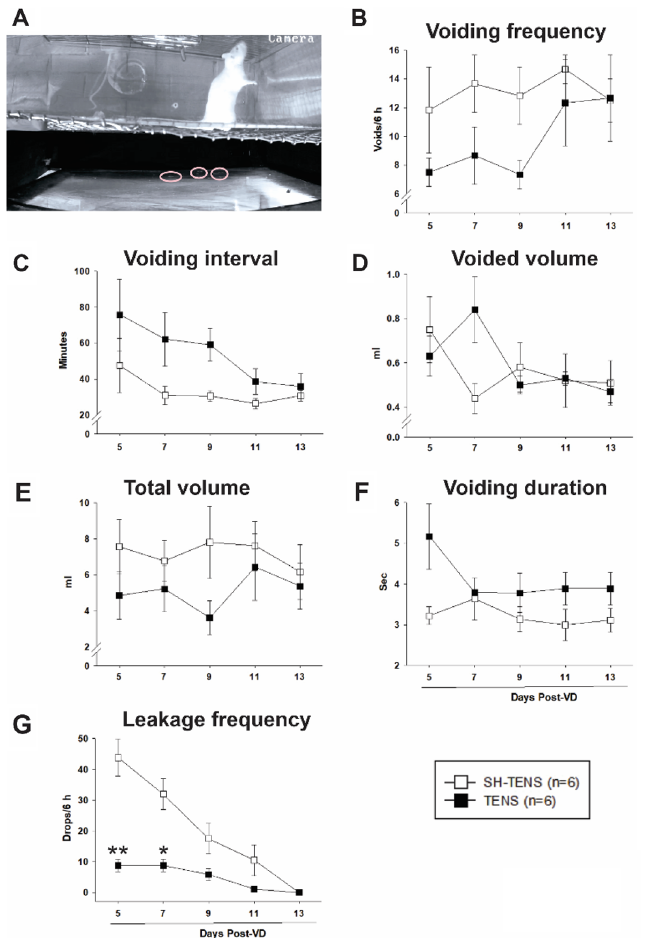
Figure 7. Urinary parameters of rats treated with transcutaneous electrical nerve stimulation (TENS) after vaginal distension (VD). ( A ) Photograph of a female rat standing on the hind-legs for vertical exploration with concomitant urine leakage (ovals indicate the drops expelled). Urinary parameters during the dark phase after VD or sham VD (SH-VD) during TENS or sham TENS (SH-TENS) treatments, including voiding frequency ( B ), voiding interval ( C ), voided volume ( D ), total voided volume ( E ), and voiding duration ( F ). ( G ) Urine leakage frequency as the number of drops in 6 h at different time points after VD with TENS or SH-TENS treatments. Values indicate mean ± standard error of the mean. *( p < 0.05), and ** ( p < 0.01) indicate significant differences for TENS values vs. SH-TENS on the same time point (two way repeated measures